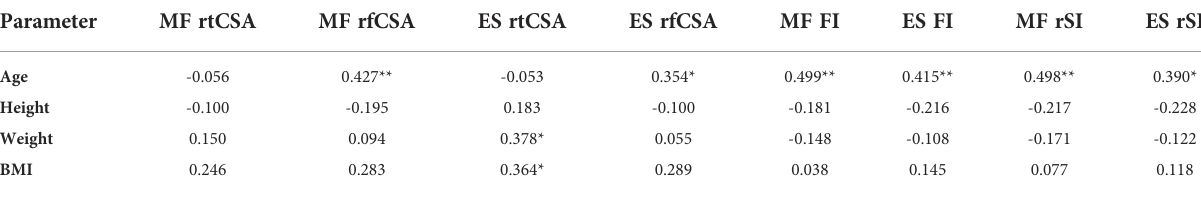
TABLE 6 Relationships between paraspinal muscle parameters and other factors in patients.